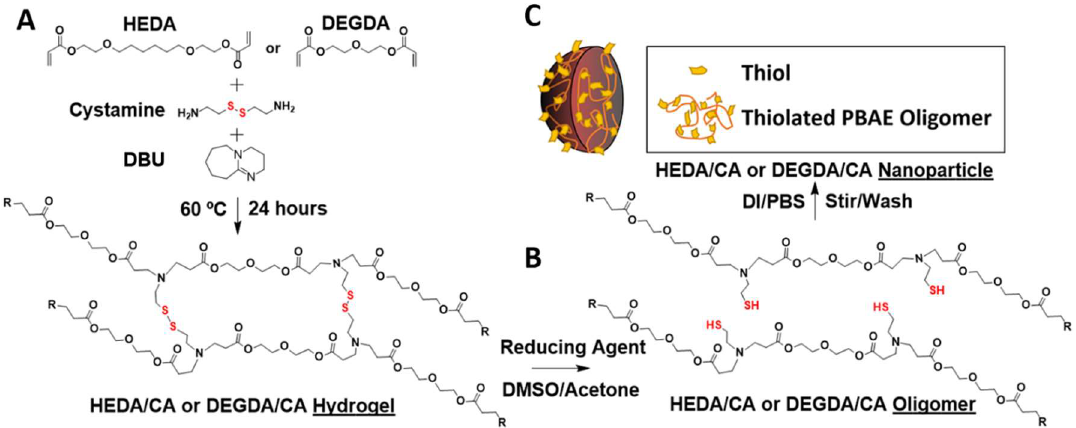
Figure 1. Hydrogel-to-nanoparticle synthesis scheme. ( A ) disulfide poly ( β -amino ester) (PBAE) hydrogel and conversion into ( B ) thiolated oligomers via a reducing agent (2-mercaptoethanol), and ( C ) single-emulsion into thiolated nanoparticles.